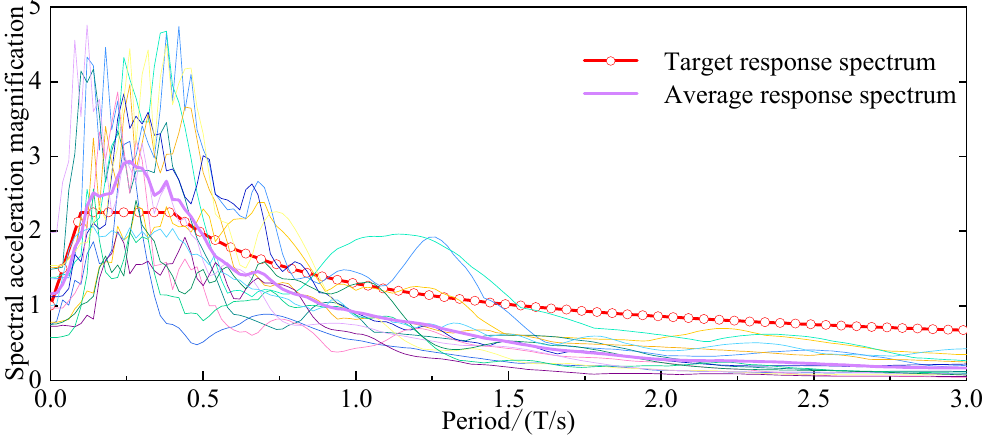
Figure 7. Response spectrum curves.